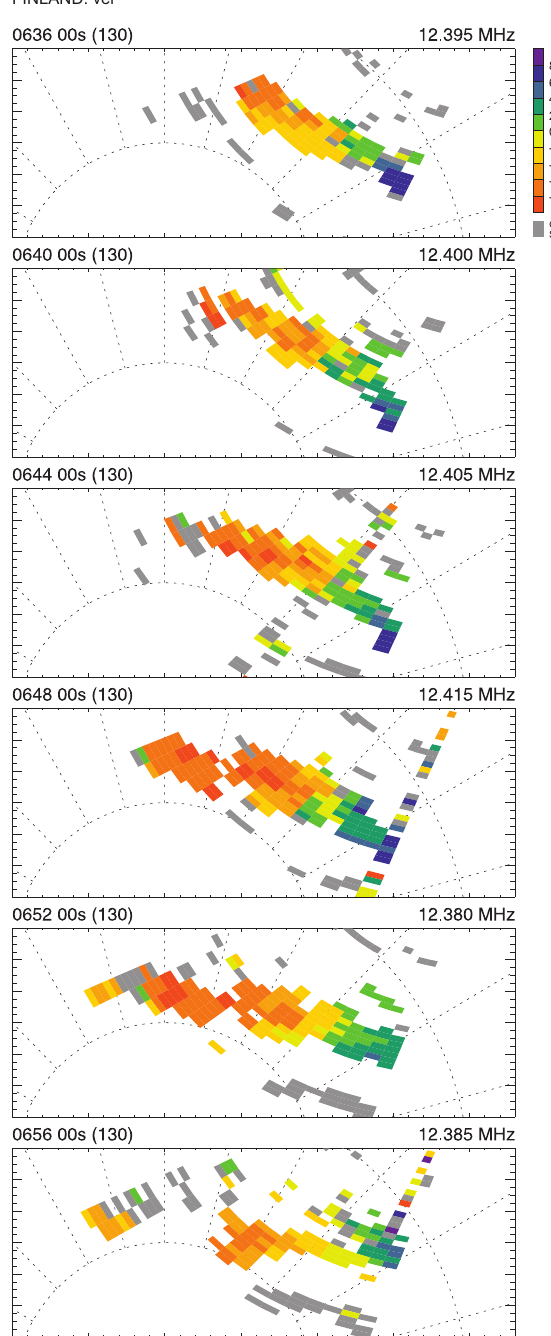
Fig. 6. The Finland radar velocity maps (magnetic local time versus magnetic latitude; 12:00 MLT is to the top) showing a poleward progressing flow